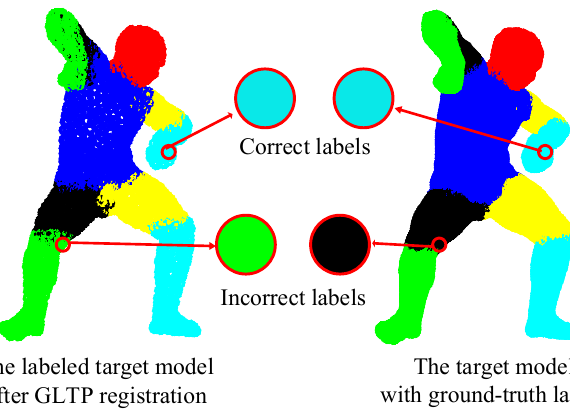
Figure 10. Illustration of the computation of segment labeling